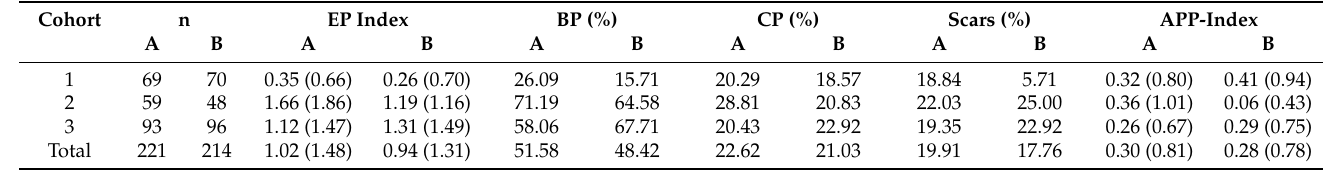
Table 2. Lung score data at slaughter for animals of group A (IM vaccine) and group B (ID vaccine). Index values are given as means and SD. EP: enzootic pneumonia, BP: bronchopneumonia, CP: cranial pleurisy, APP: A.pp. -pleuropneumonia.